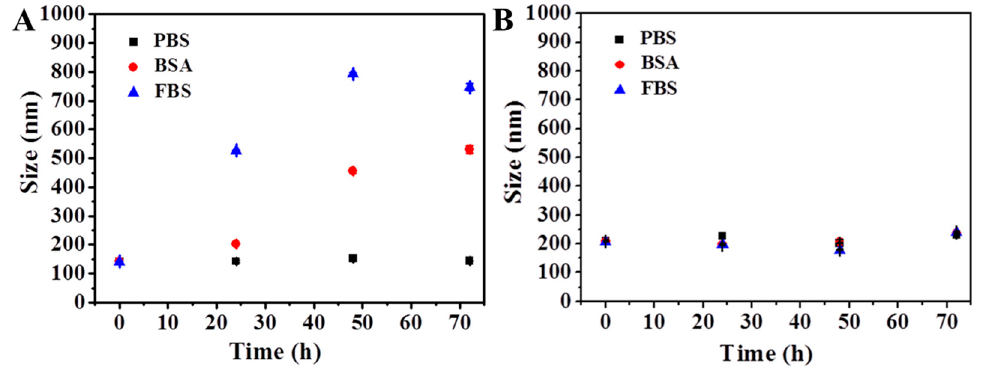
Figure 5. Size change of ( A ) MSNs@PDA and ( B ) MSNs@PDA-PSPP cultured in phosphate buffer saline (PBS), bovine serum albumin (BSA, 1 mg/mL) and 10% ( v / v ) fetal bovine serum (FBS) solution for 72 h.